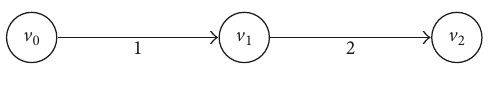
Figure 1: Linear network without